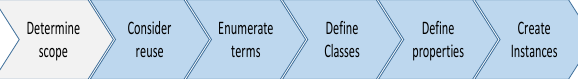
Figure 4 - Steps for Ontology Development (Hartung